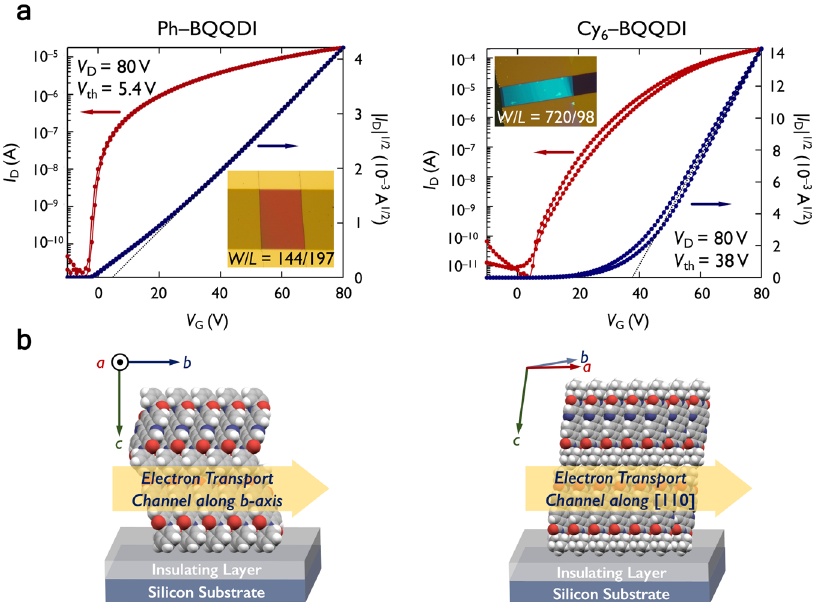
Fig. 5 OFET performances and thin- fi lm assemblies of Ph – BQQDI and Cy 6 – BQQDI. a Optical microscopic images and transfer characteristics of single- crystalline transistors (black dashed lines represent the fi t to | I D | 1/2 , from which the µ e are estimated), where V D and V th are drain and threshold voltages. b Molecular assemblies in device states and the corresponding channel